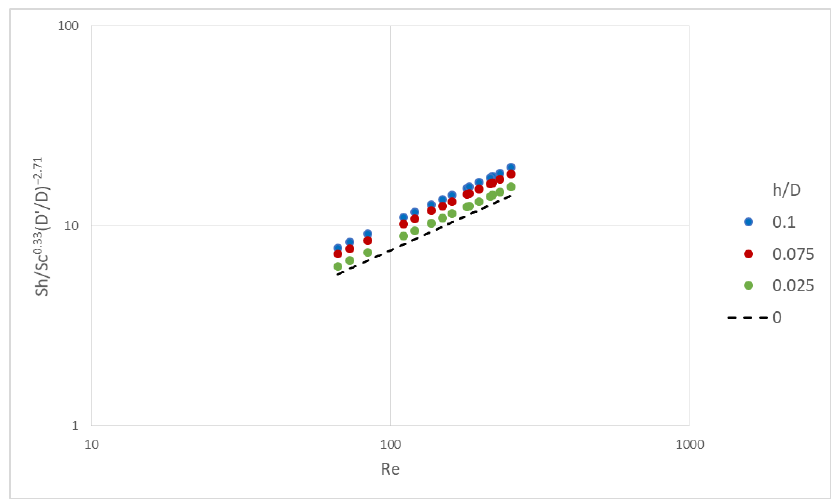
Figure 10. Generalized correlation of Sh as a function of Re number, accounting for D’/D. Solid line corresponds to Equation (11) and dotted line to Equation (12).